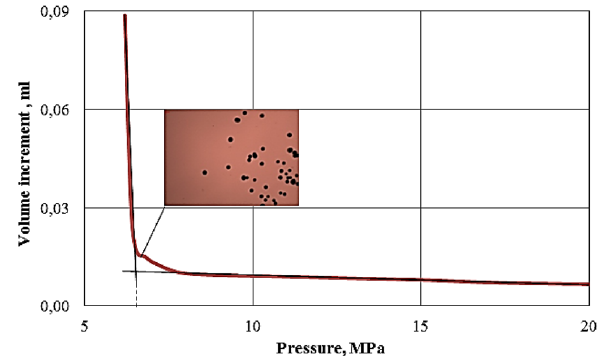
Fig. 3 Volume increment of oil versus pressure at reservoir tempera- ture (48 °C)